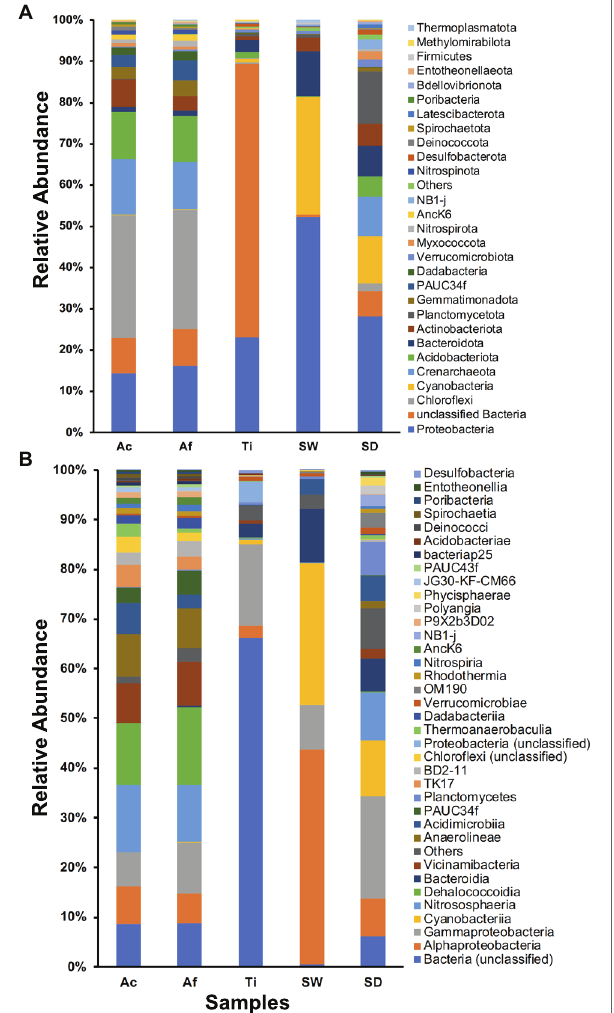
FIGURE 2 | Prokaryotic community composition for Ac ( Aplysina caissara ), Af ( Aplysina fulva ), Ti ( Tedania ignis ), SW (seawater), and SD (sediment) is shown for 28 prokaryotic phyla (A) and for 36 classes with relative abundance >0.2% (B) .